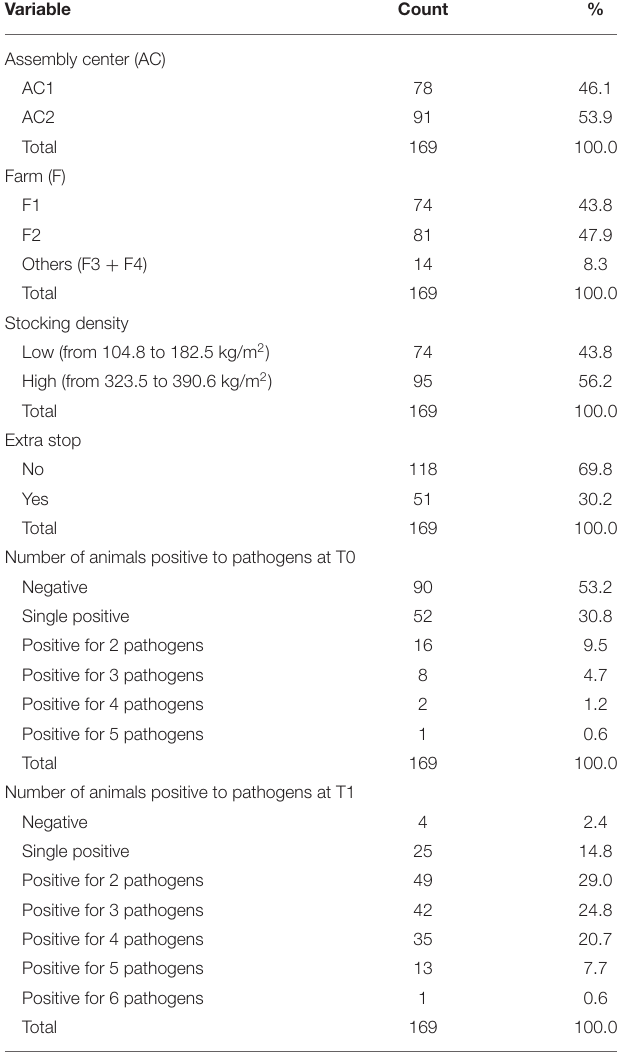
TABLE 2 | Frequency table of beef steers ( n = 169) transported from France to Italy for the variables related to travel conditions and co-infection at T0 (departure) and T1 (4 days after